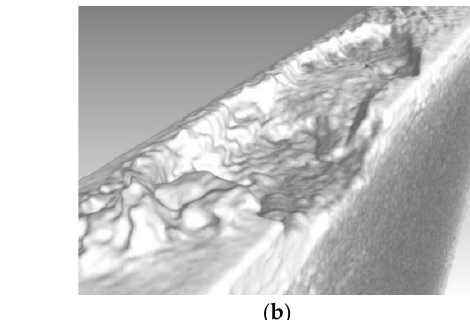
after mechanical testing.